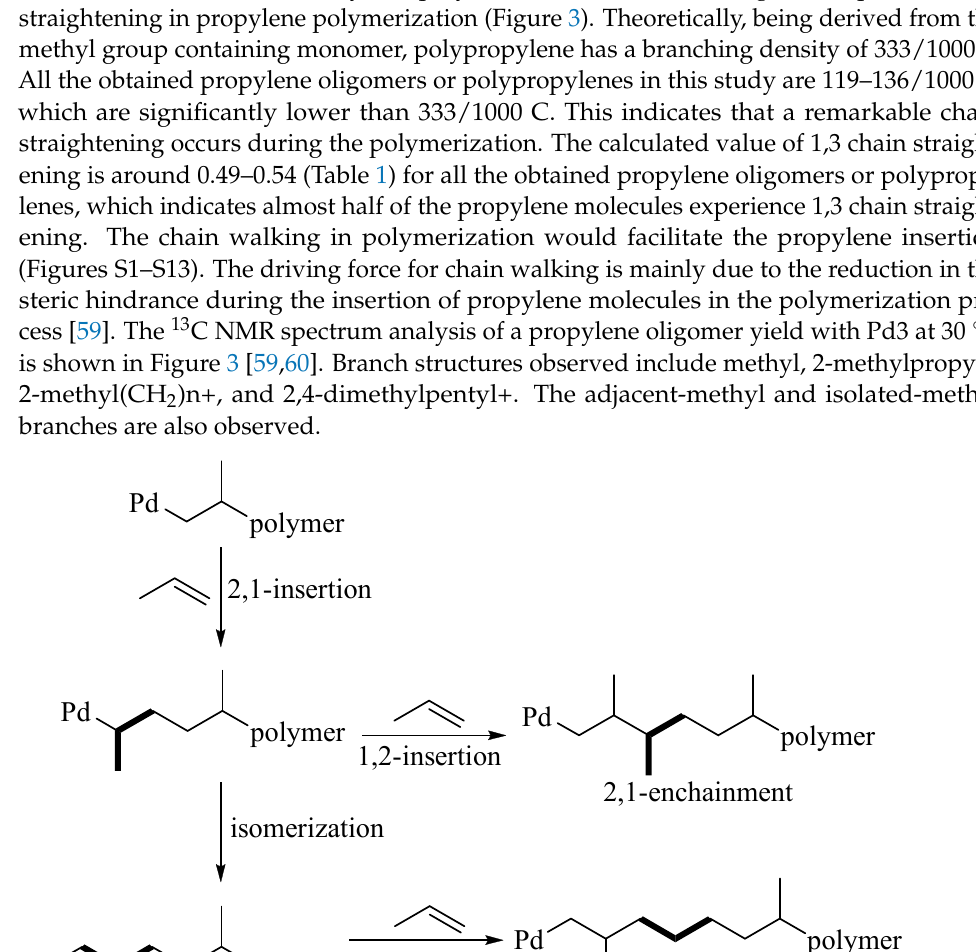
Figure 3. 13 C NMR spectrum analysis of the partially chain-straightened propylene oligomer ob- tained by using Pd3 at 30 o C (Table 1, entry 5). The performance of the iminopyridyl Pd(II) complexes in propylene − MA copoly- merization was also explored (Table 2). In this study, polar-functionalized propyl-